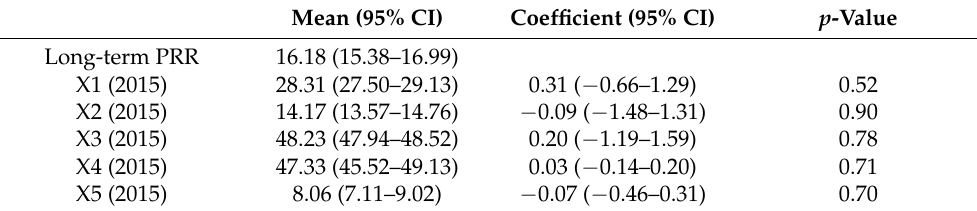
Table 4. Associated factor analysis for long-term polypharmacy reduction